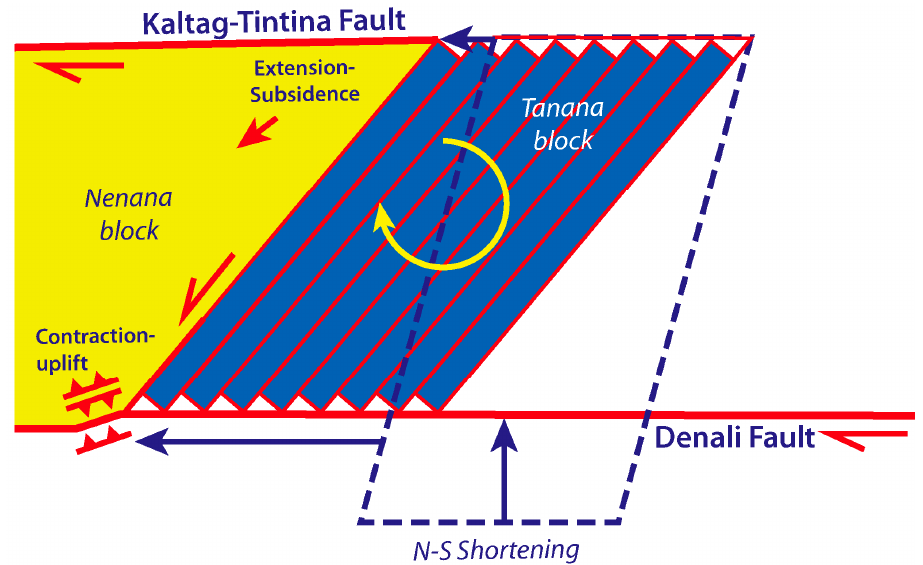
Figure 15. Simplified regional tectonic deformation model proposed for Central Interior Alaska.